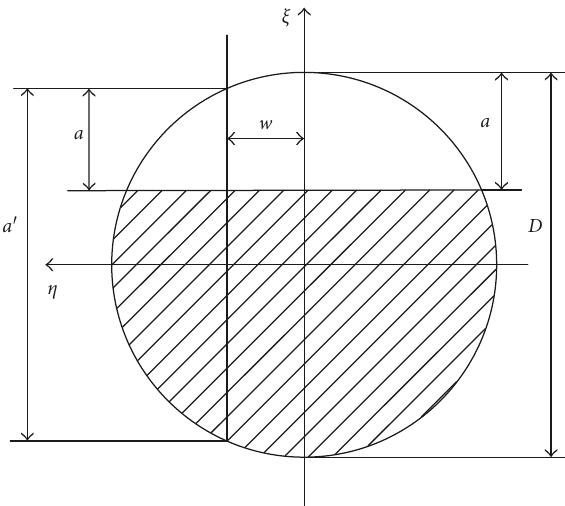
Figure 3: Cross-section at the crack